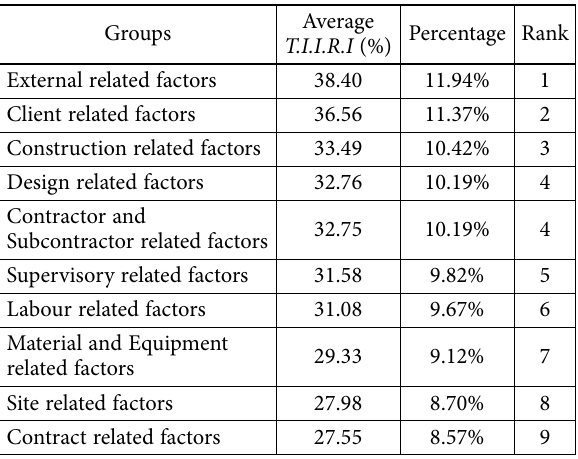
Table 14. The rank of each rework group